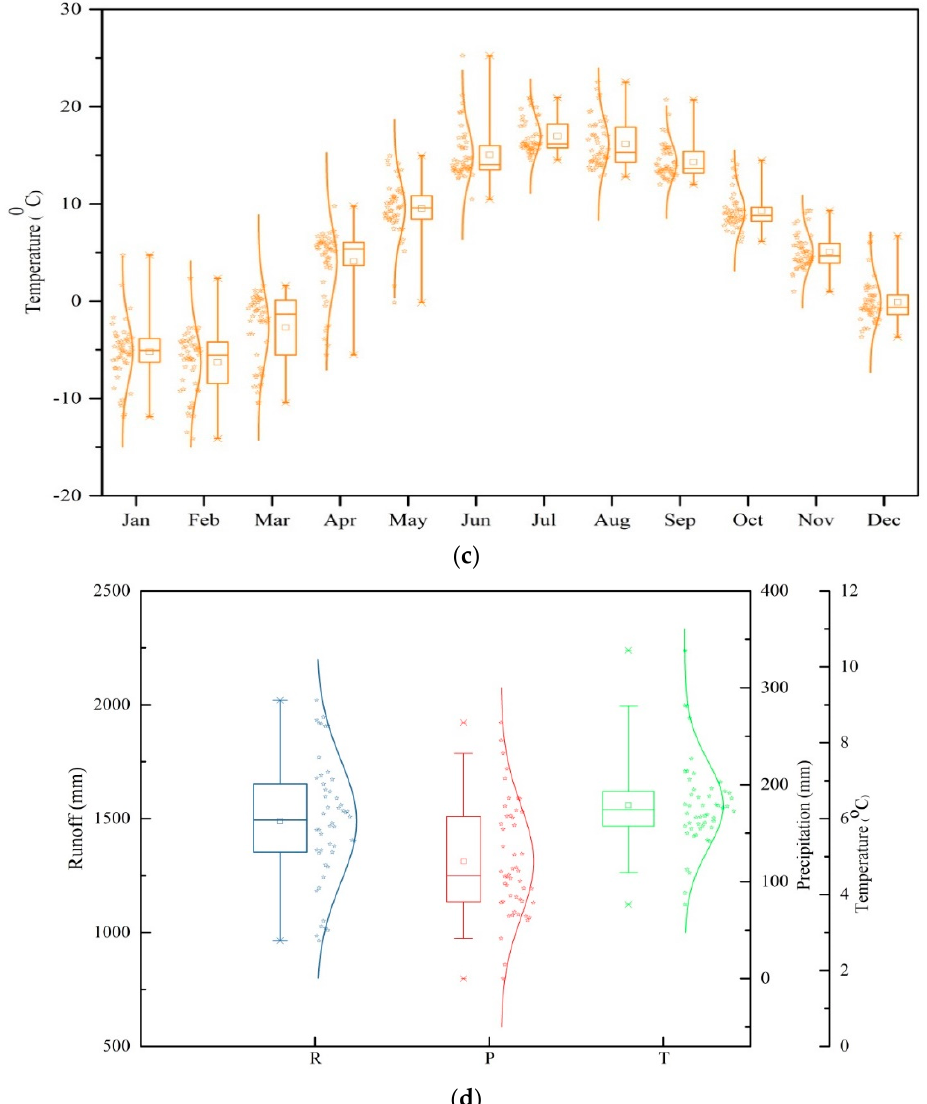
Figure 2. Box plot and distribution of precipitation, runoff and temperature Zone I. ( a ) monthly precipitation, ( b ) monthly runoff, ( c ) monthly temperature, ( d ) annual runoff, precipitation and temperature.